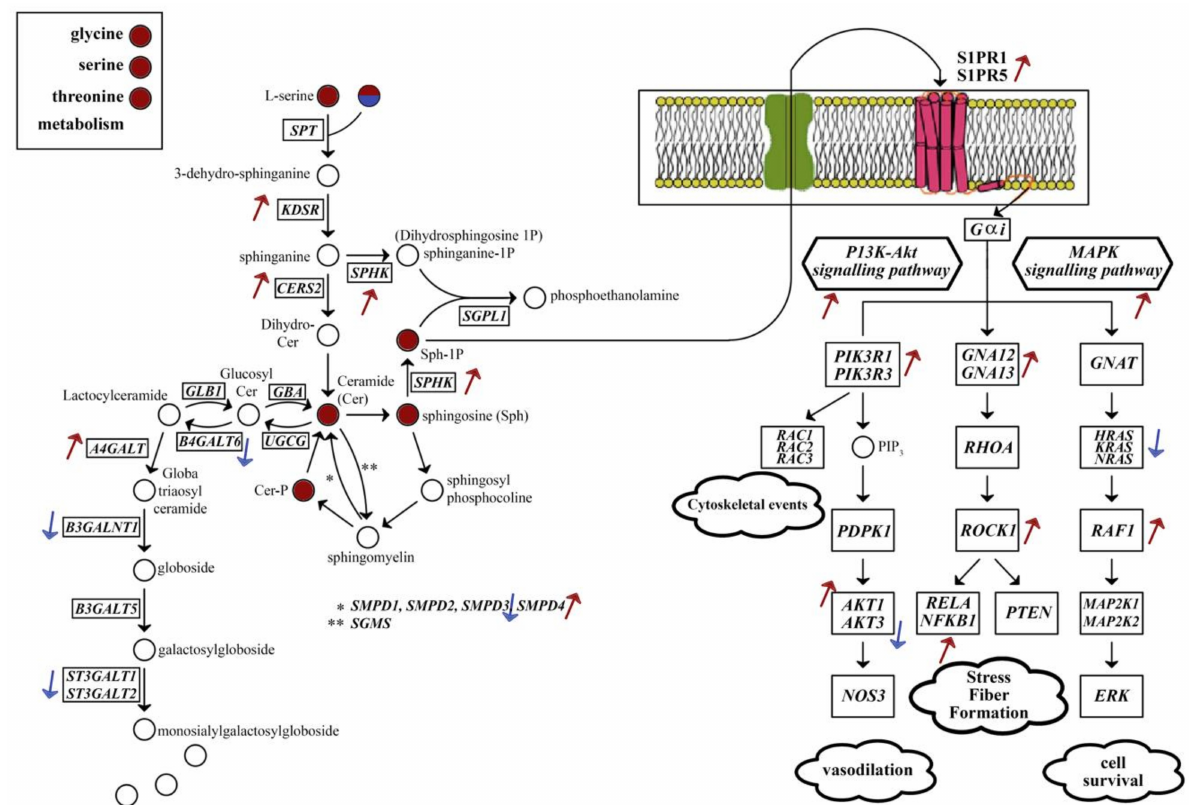
Figure 9. Sphingolipid biosynthesis and affected signalling pathways in DLPFC. There is an overall increase in sphingolipid synthesis. The increase in sphingosine-1-phosphate also induces MAPK and P13K/Akt signalling pathways, which are associated with cytoskeletal events, vasodilation, fibre formation and cell survival. Circles representing metabolites: red for up-regulated genes, red/blue is palmitoyl–CoA reported for both down-regulated and up-regulated genes. Boxes representing reaction catalysing genes. Arrows represent the direction of significant gene expression level